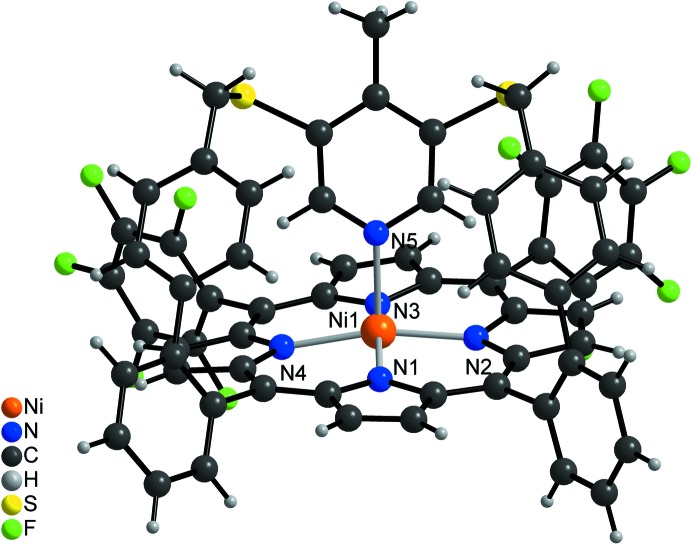
Mol­ecular structure of the title compound showing the square-pyramidal NiII coordination.